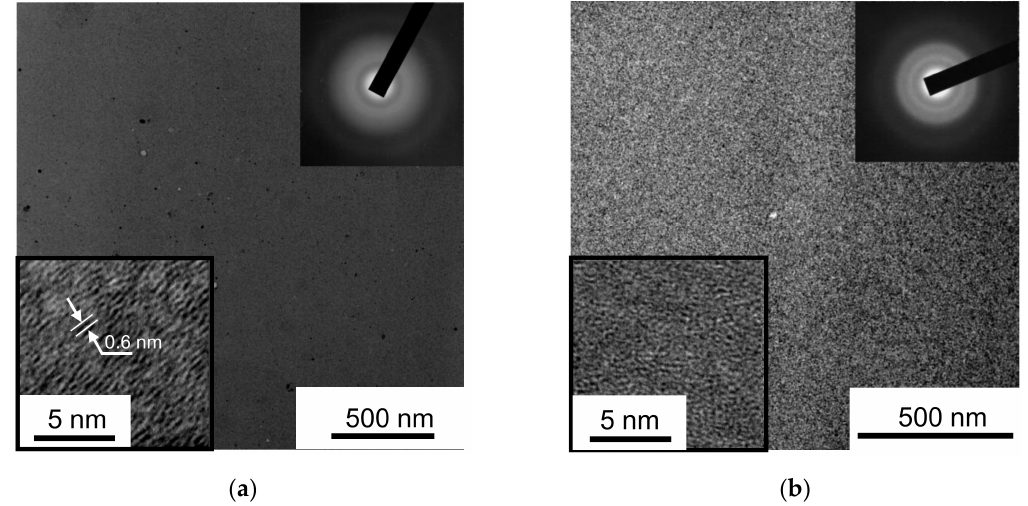
Figure 3. TEM images and selected area diffraction (SAED) patterns of the thin films obtained through RPLD: ( a ) MoS 2 and ( b ) MoS 3 . The bottom inserts show high-resolution TEM images of the films.